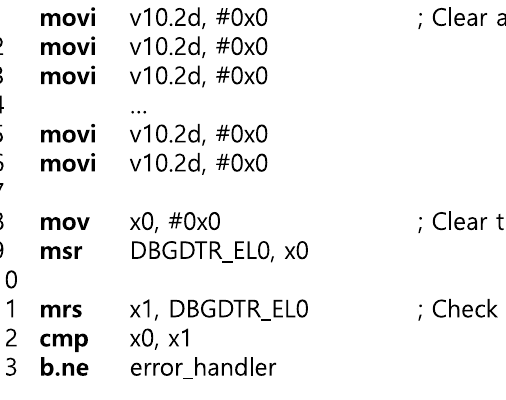
Figure 6. Exit gate of